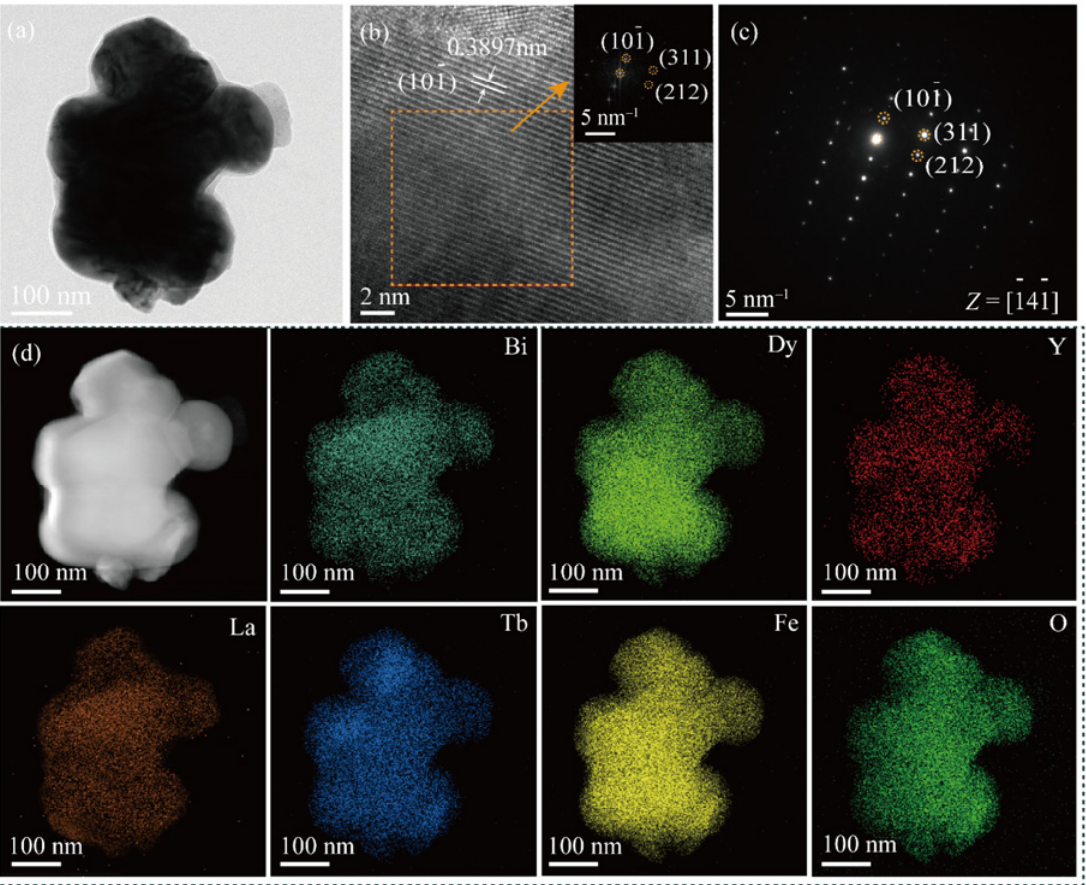
Fig. 7 Micrographs of high-entropy BLYDTFO ceramics: (a) TEM image, (b) HRTEM image (the inset shows FFT of HRTEM image), (c) SAED pattern, and (d) EDS mappings of element